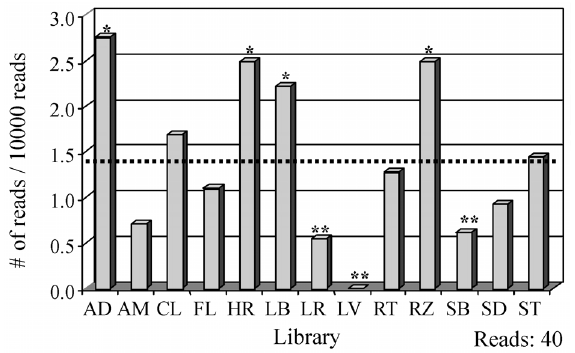
Figure 1 - Distribution of reads of the photolyase gene family. The dashed line represents the average of reads observed in all tissues and those indi- catedby(*)or(**)aresignificantlydifferentfromtheaverage(P<0.01as determined by the T-test